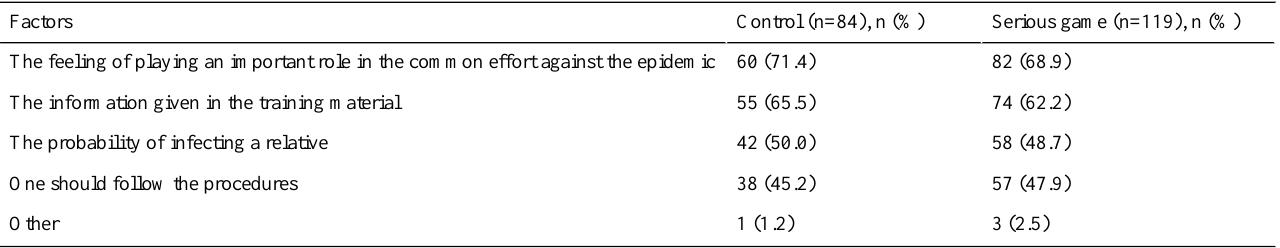
Table 2. Factors underlying the willingness to change infection prevention and control behavior.